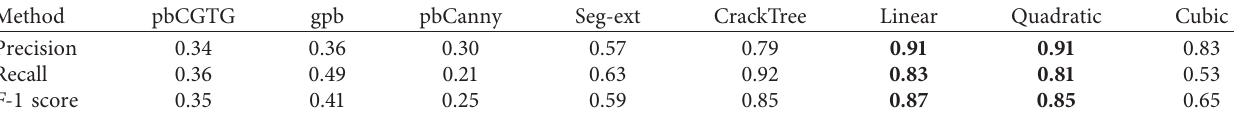
Table 3: Comparison of the crack detection performance between eight different methods [41].